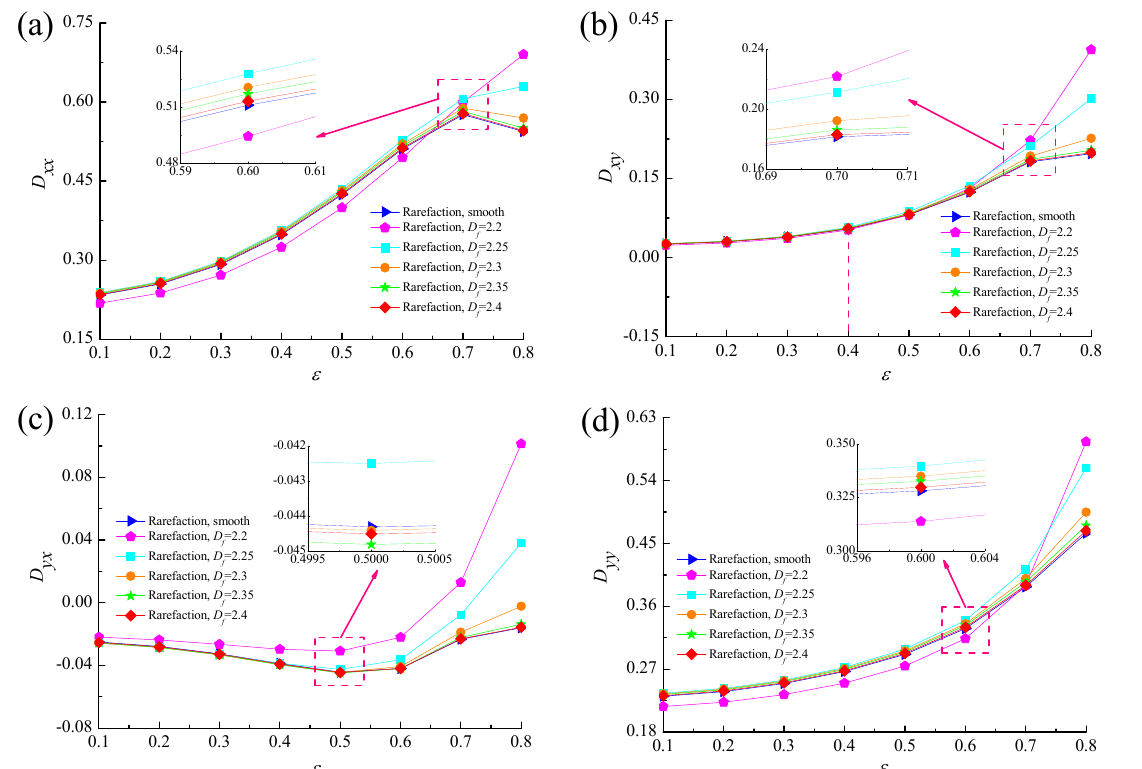
Figure 15. Effect of eccentricity ratio on dynamic damping coefficients with different fractal dimensions. ( a ) D xx vs. ε ; ( b ) D xy vs. ε ; ( c ) D yx vs. ε ; ( d ) D yy vs. ε.